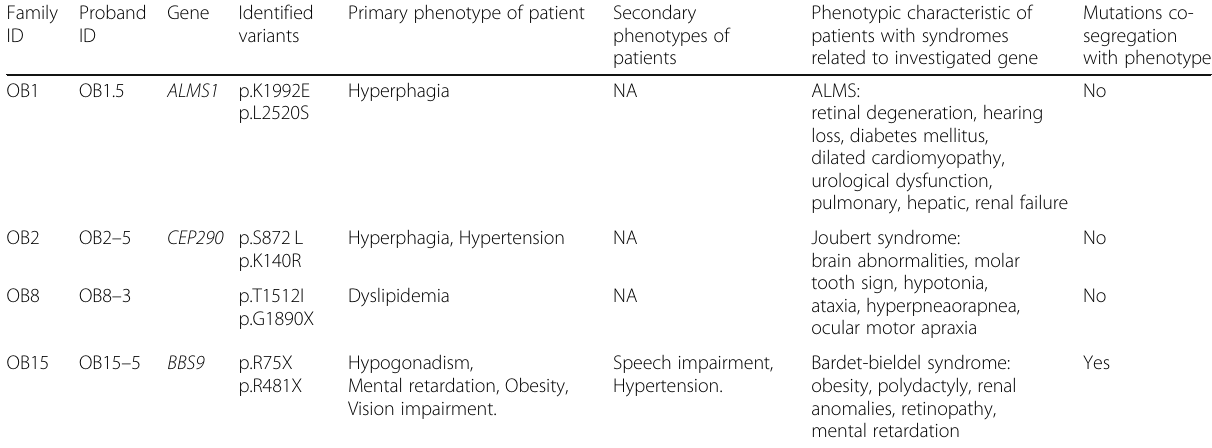
Table 2 Mutation type and phenotypic presentation in probands carrying two heterozygous variants within the same gene Family